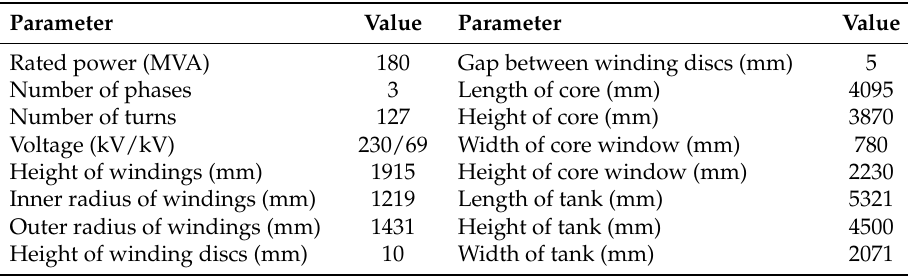
Table 1. Characteristics of the simulated transformer.